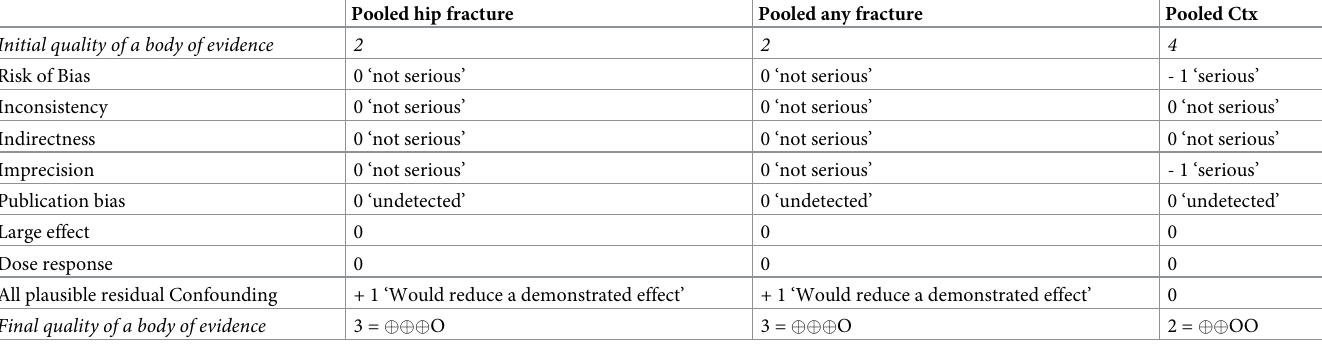
Table 3. Grading of Recommendations Assessment, Developing and Evaluation used to assess the systematic review outcomes.